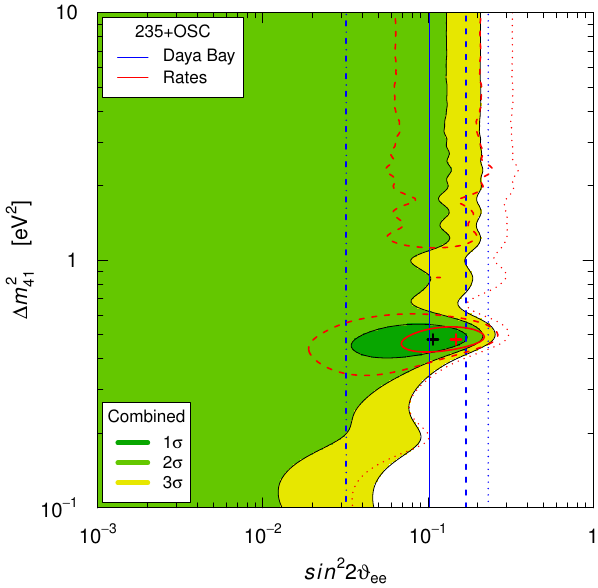
Figure 5 . Allowed regions in the sin 2 2 # ee {(cid:1) m 2 plane obtained from the (cid:12)t of the Daya Bay 41 evolution data [11] (Daya Bay), from the (cid:12)t of the reactor rates (Rates), and from the combined (cid:12)t (Combined) with the 235+OSC model. The best (cid:12)t points are indicated by crosses, except for the (cid:12)t of the Daya Bay evolution data for which the best (cid:12)t is the vertical dash-dotted line. For the Daya Bay and Rates (cid:12)ts the 1 (cid:27) , 2 (cid:27) , and 3 (cid:27) allowed regions are limited, respectively, by solid, dashed, and dotted